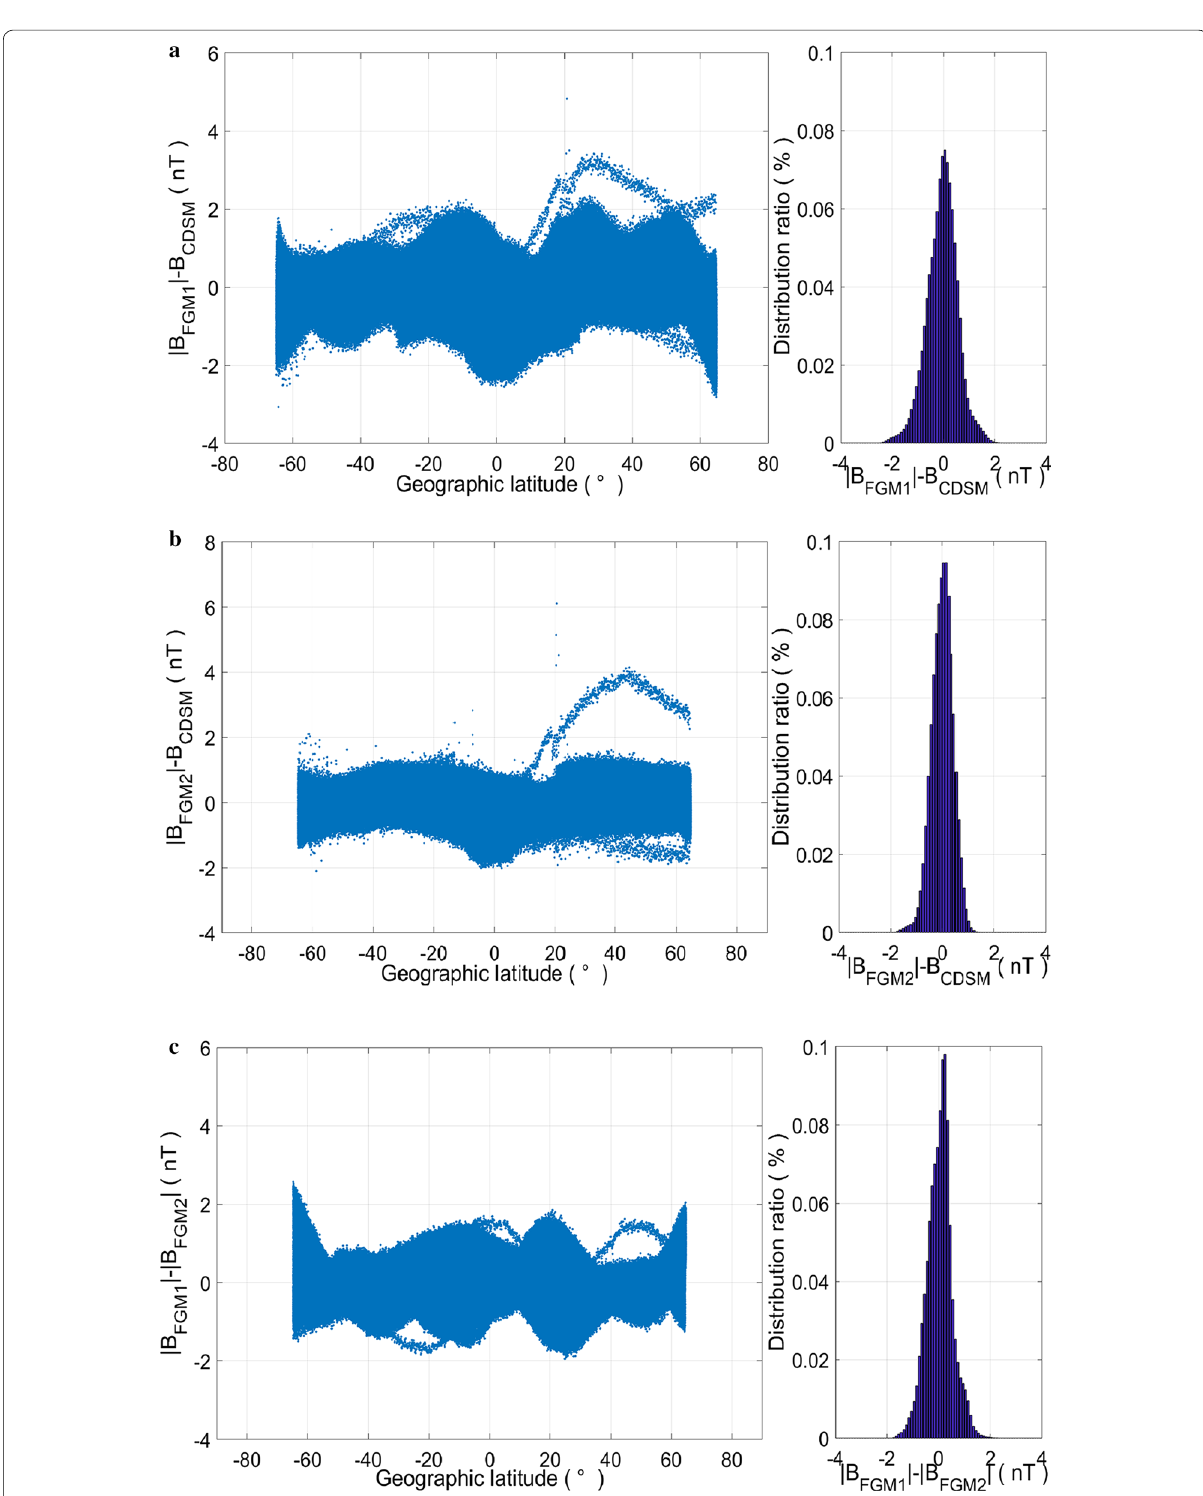
Fig. 19 The scalar deviations between FGM 1, FGM 2 and CDSM data are from August 2018; the interferences from the TBB and the magnetic torquer are removed before calculating